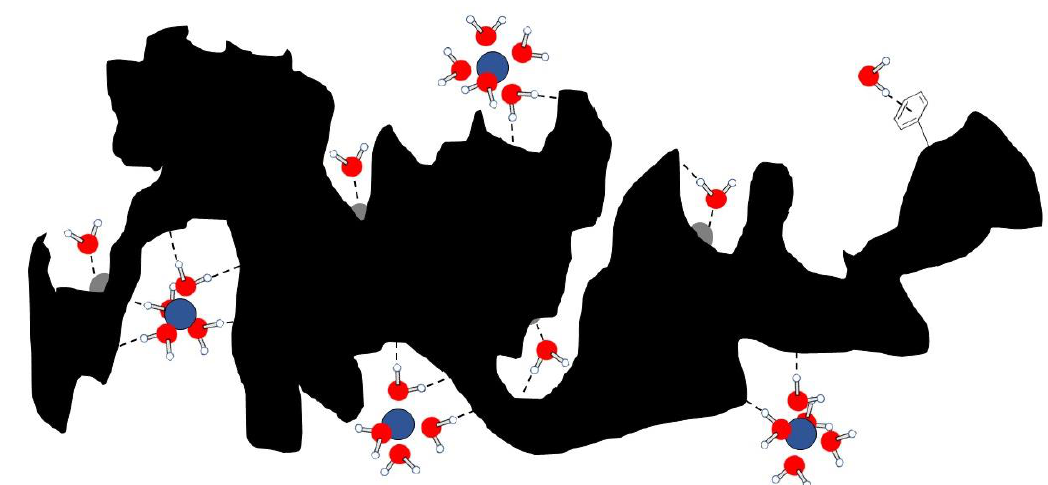
Figure 14. Different possible bindings between water molecules and biochar. Water can interact with biochar’s surface by OH–π bonding, Van der Waals interactions, and coordination linkages. The latter occur when the electron-rich oxygen in water lays in the proximity of a metal ion (dark grey outgrowths). The blue spheres represent a solvated cation (e.g., ammonium).